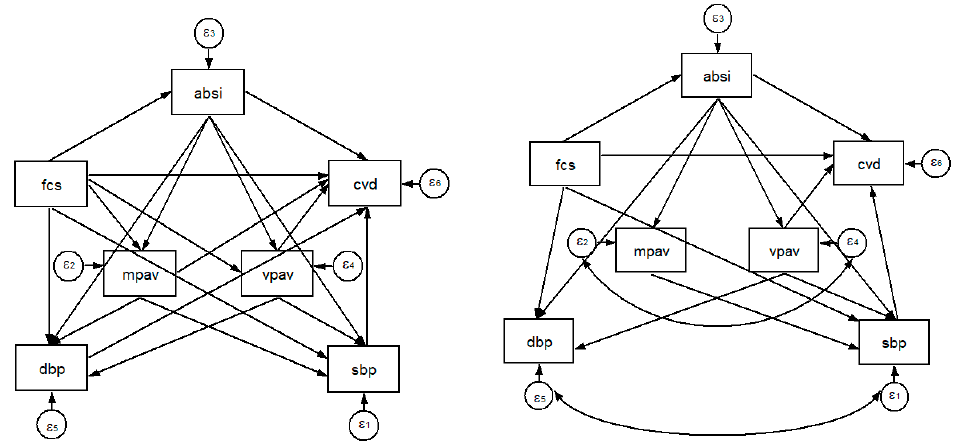
Figure 1. The hypothesised model ( left ) and final model ( right ) of the structural equation modelling (SEM).